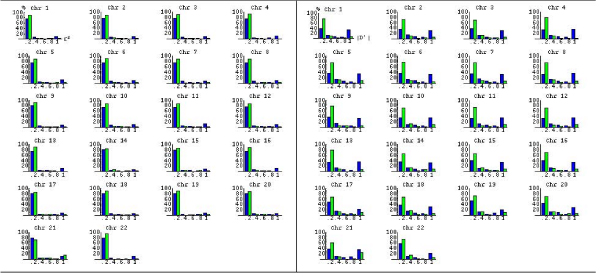
LD frequency across Affymetrix and Illumina SNP maps. LD frequency distribution of Affymetrix (blue/black bars) and Illumina (green/gray bars) SNP maps, as measured by r2 (left) and |D'| (right). Bar names are the LD category boundaries. Note "U" shaped distribution of the LD content of Affymetrix map, and the general increase of LD, when measured as |D'|.